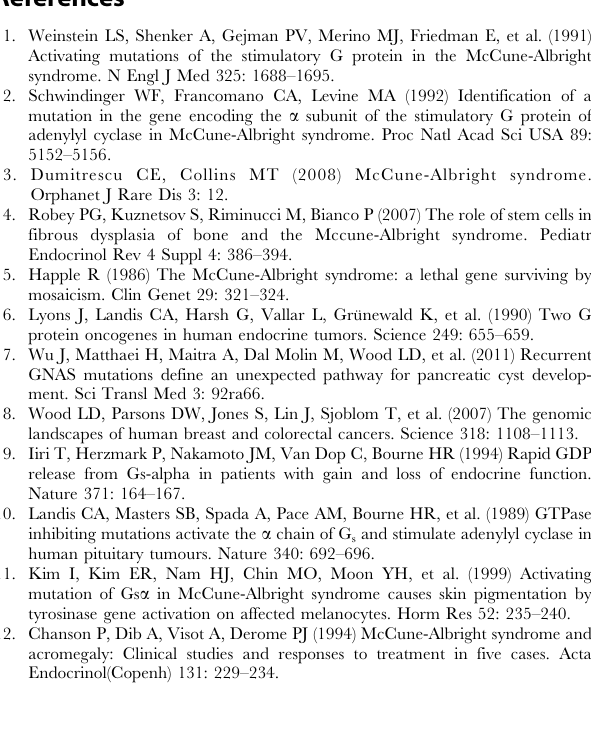
Table S2 LOPAC Screen Curve Class Definitions. (TIF) Table S3 LOPAC Screen Curve Class Activity Summary. (TIF) Table S4 A. LOPAC Screen Cherry Pick Criteria. B. LOPAC Screen Cherry Pick Results. (TIF) Table S5 Cluster Analysis Compounds with molecule identifier, structure, IC50, and active link to a full description of the molecule in